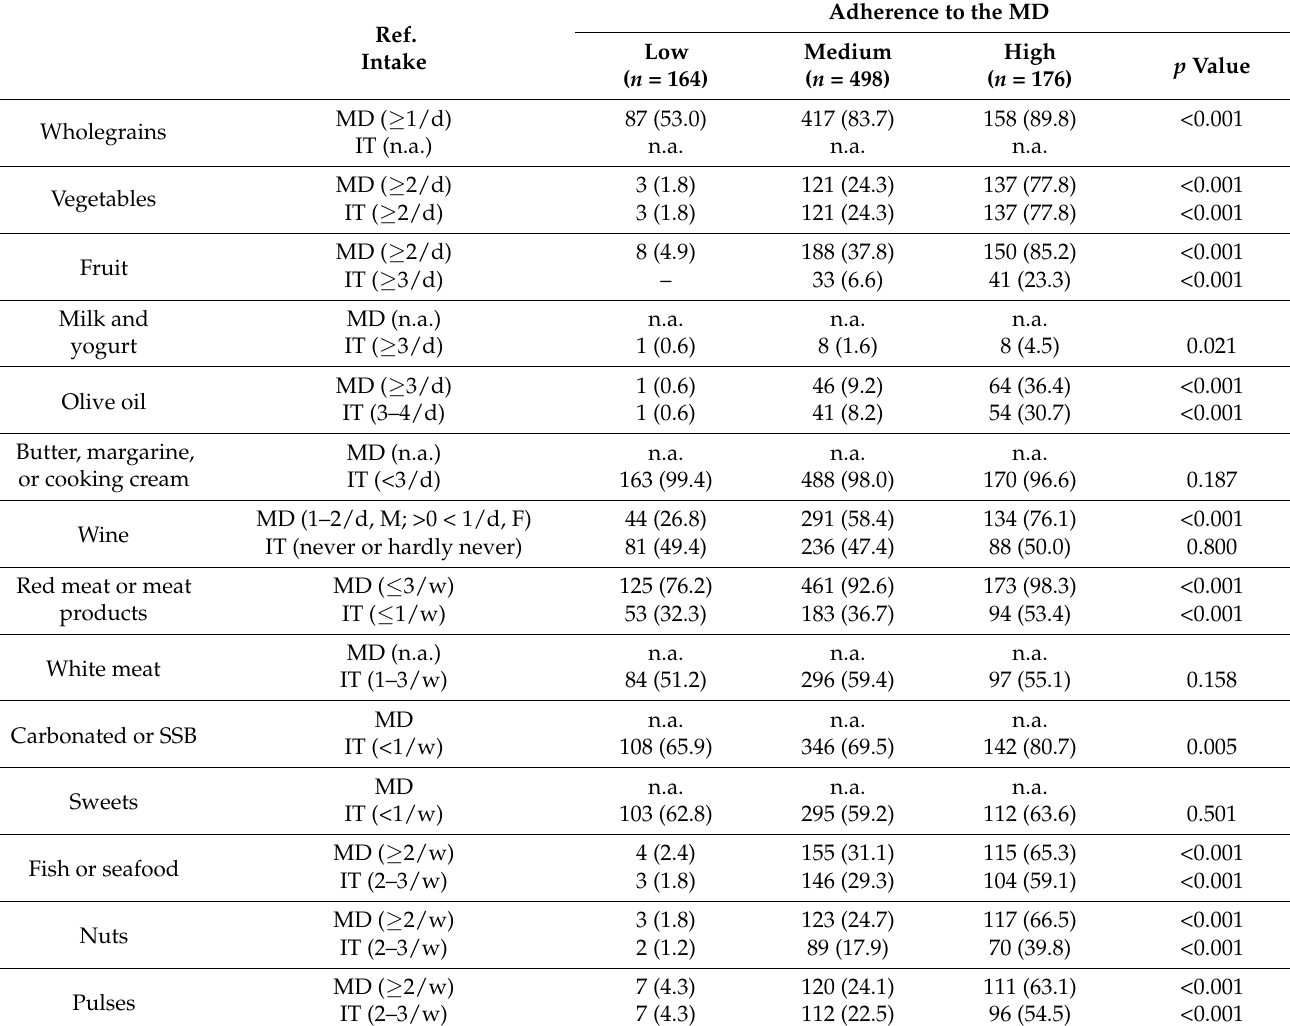
Table 2. Compliance with food consumption recommendations used to compute the MD score (MD) and following the Italian guidelines (IT) for healthy eating for a standard dietary energy intake of 2000 kcal/day, according to the level of adherence to the